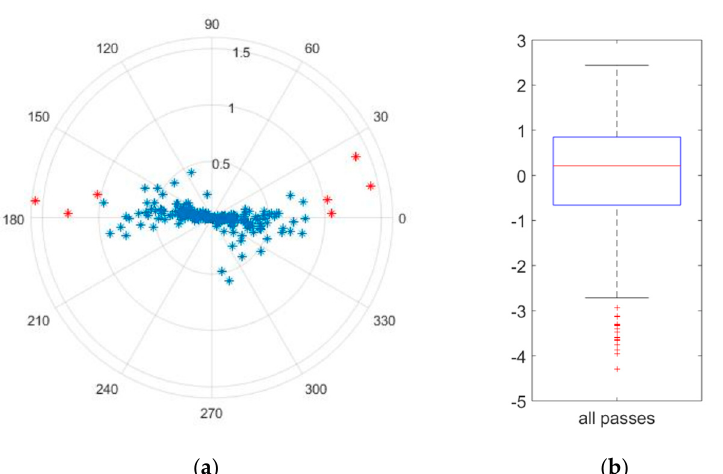
Figure 3. The normalized precision ( a ) in % on the r-coordinate. The passes that exceeded the limit of 1% are marked in red. The accuracy of the pass distance prediction is shown in % in ( b ). The parameters used for the forecast are listed in Table